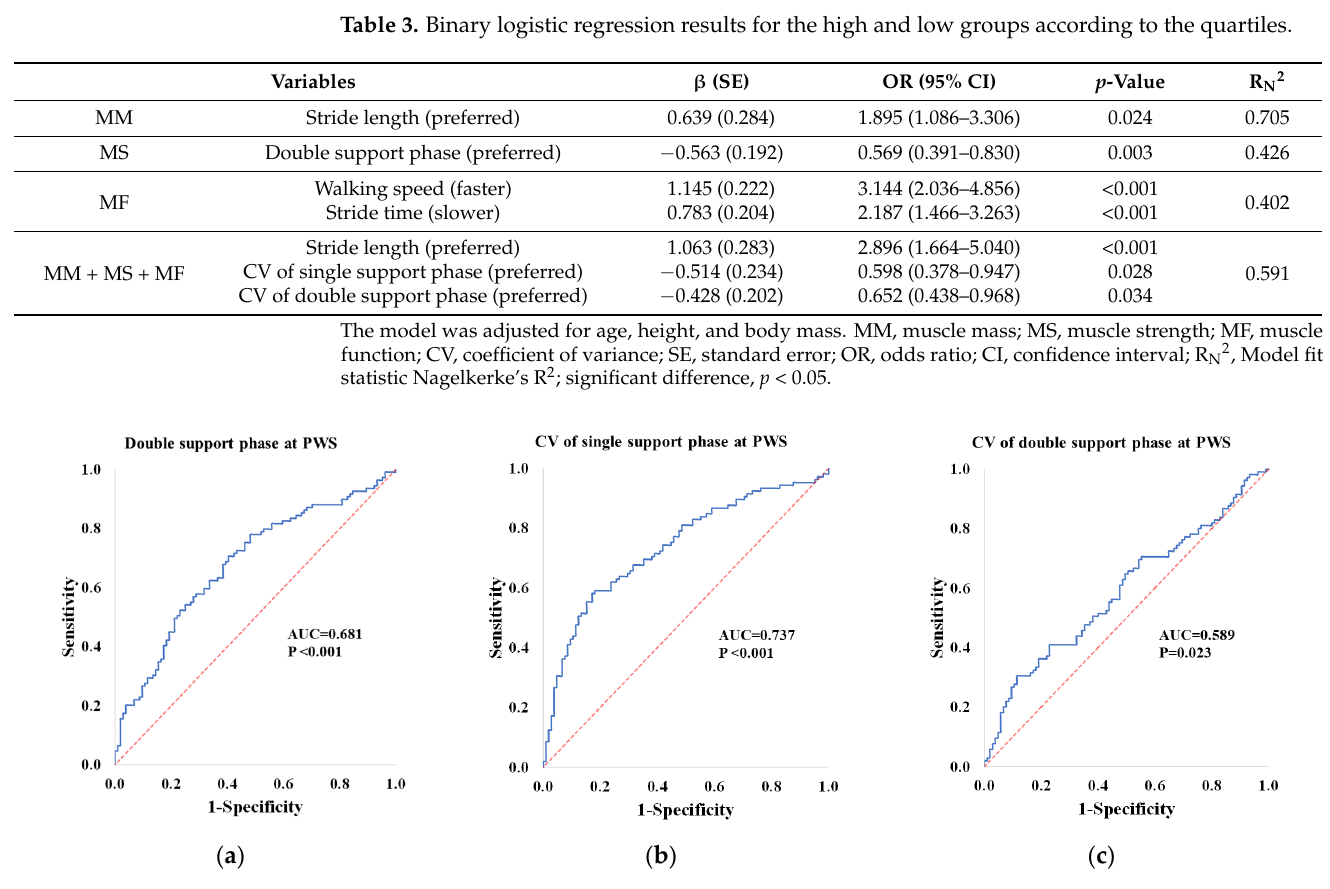
Figure 5. Receiver operating characteristic (ROC) curves of the double support phase and CVs of single and double support phases at PWS: The AUC and p -values of the ROC curves are written in bold style at the bottom-right corner of each panel. AUC: area under the curve; PWS: preferred walking speed; CV: coefficient of variance.